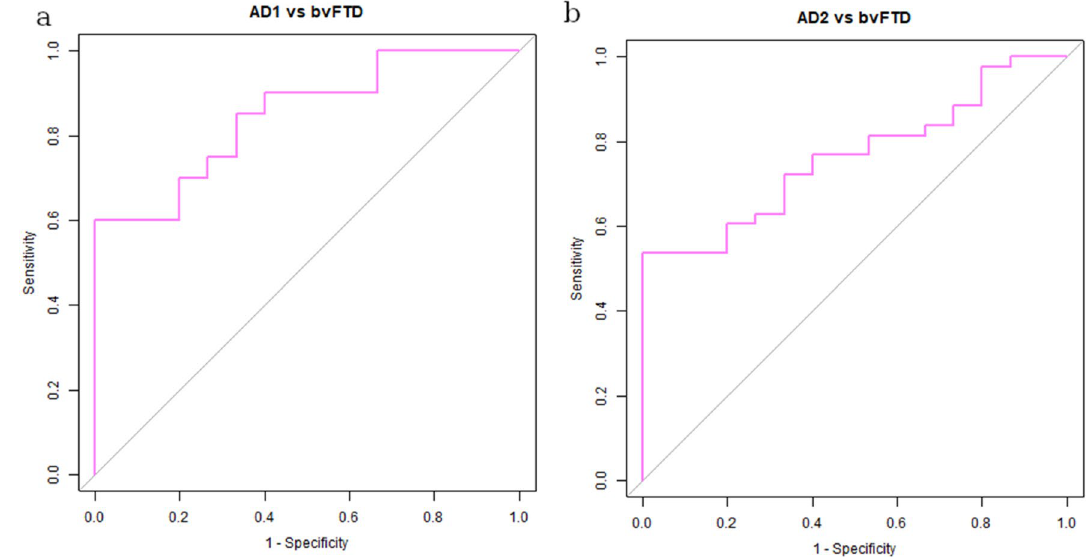
Figure 5. Receiver operating characteristic (ROC) curves for Alzheimer’s dementia (AD) and behavioral variant frontotemporal dementia (bvFTD) for ( a ) AD identification group (AD1) and ( b ) internal AD validation group